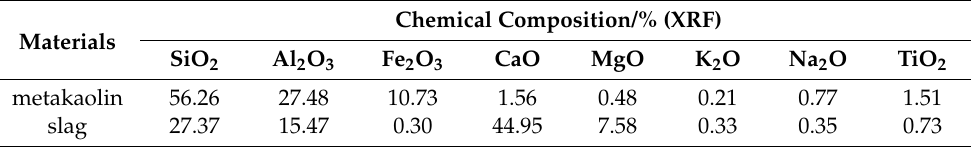
Table 1. Chemical composition of raw